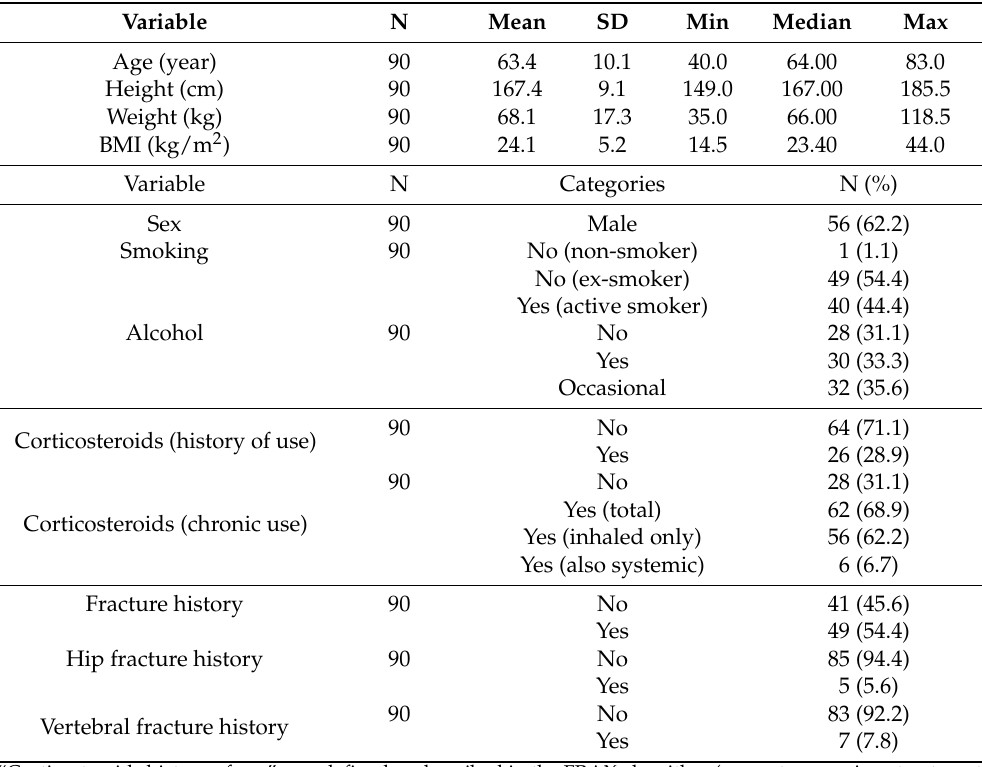
Table 1. Demographic and clinical data for the 90 COPD